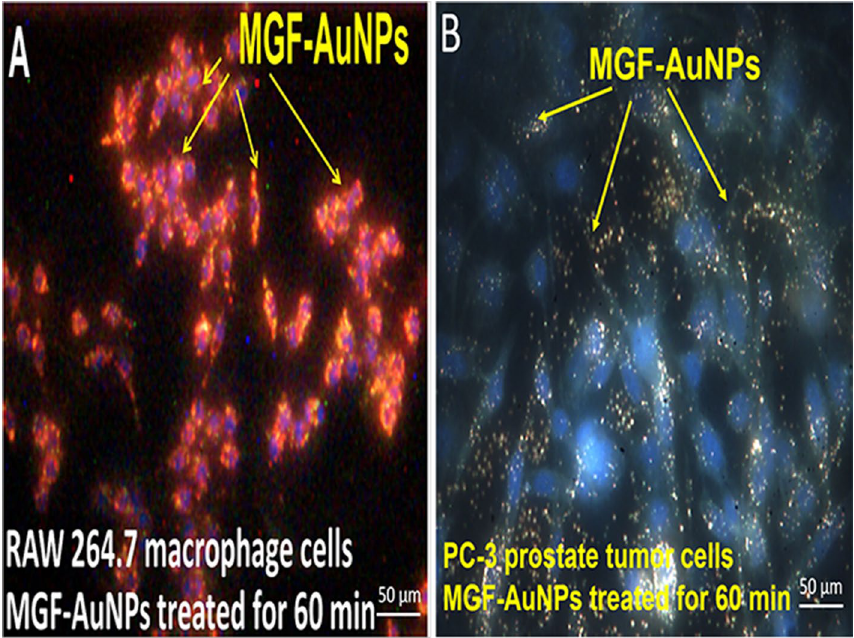
Figure 7. Macrophages internalize MGF-AuNPs more than PC-3 cells. ( A , B ) RAW 264.7 and PC-3 were cultured in 6 well plates for overnight. The cells were then incubated with MGF-AuNPs for 1 h followed